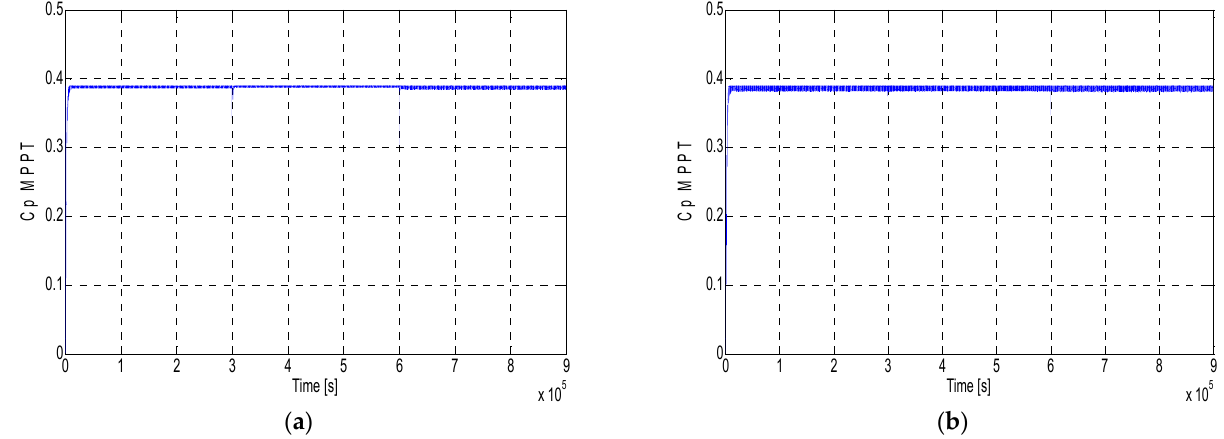
Figure 18. MPPT power efficiency of the wind turbine associated with the SRG: ( a ) For θ on = 19 ◦ and θ off = 38 ◦ ; ( b ) For θ on = 22 ◦ and θ off = 35 ◦ . Figures 19 and 20 show, respectively, the hysteresis-controlled current and the dif- ferent output powers curves for different wind speeds and switching angles: ( θ (cid:2925)(cid:2924) = 19°, θ (cid:2925)(cid:2916)(cid:2916) = 38°) and ( (cid:2925)(cid:2924) = 22°, (cid:2925)(cid:2916)(cid:2916) = 35°). The impact of changing switching angles on torque performance, current, energy efficiency and power quality have been clearly shown. In addition, MPPT importance has been also highlighted. Indeed, comparing cases of switching angles ( θ on = 19 ◦ , θ off = 38) and ( θ on = 22, θ off = 35 ◦ ), as shown in Figures 17 and 18, we can observe that power coefficient C p oscillations or torque ripples are clearly decreased in the case where ( θ on = 19 ◦ , θ off = 38 ◦ ) compared to the case where ( θ on = 22 ◦ , θ off = 35 ◦ ). Accordingly, it becomes necessary to search for appropriate algorithms to determine the correct control parameters in real time for optimal performance.